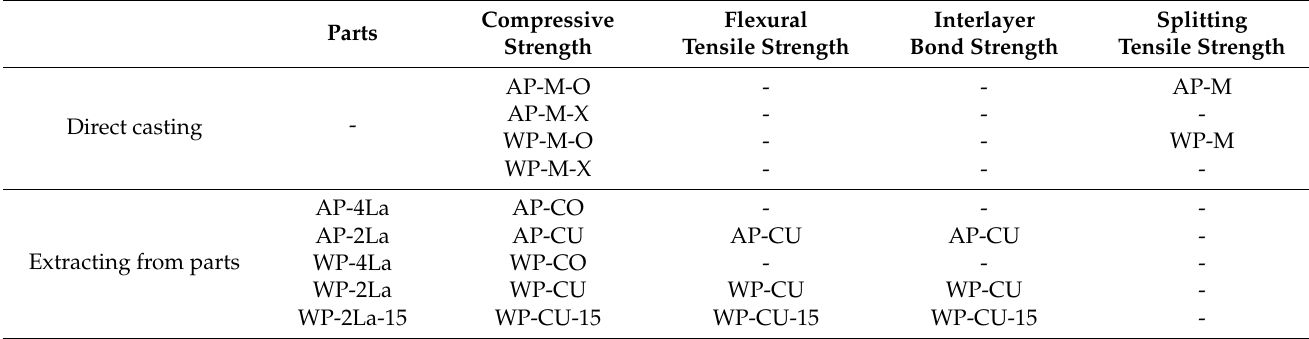
Table 2. Classification of specimens according to specimen manufacturing method and test